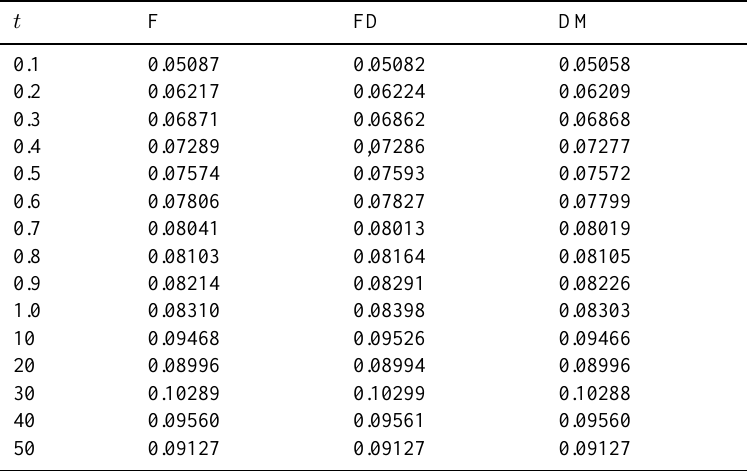
Table 1. Values of j u ( x; t ) j for x = L = 15 , (cid:13) = 2 and (cid:14) ( x ) = 0